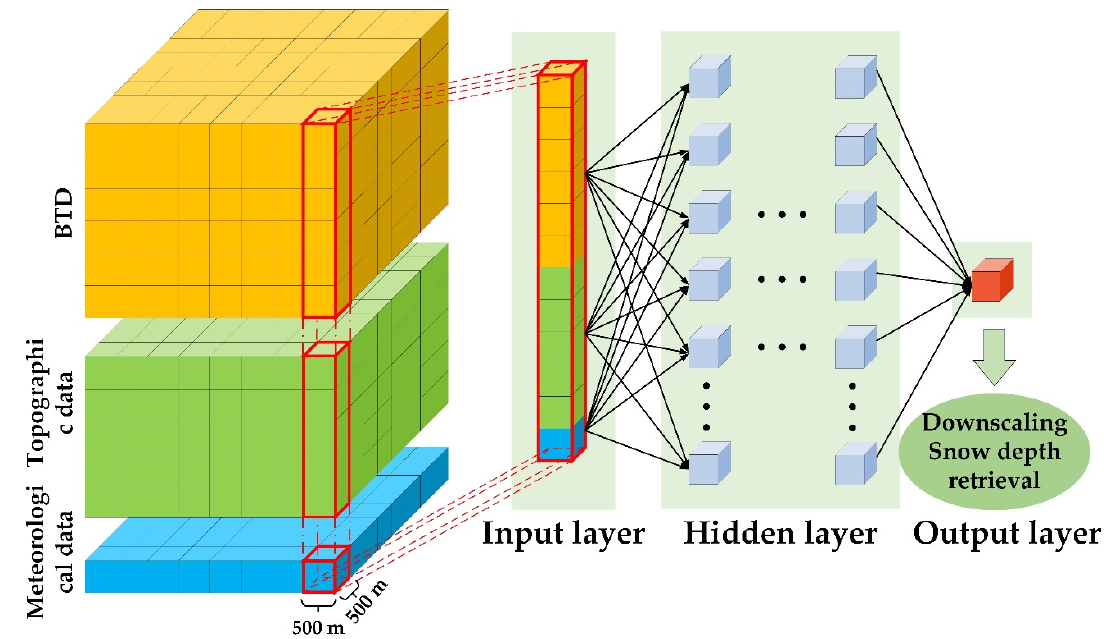
Figure 5. Framework of deep neural network for downscaling snow depth